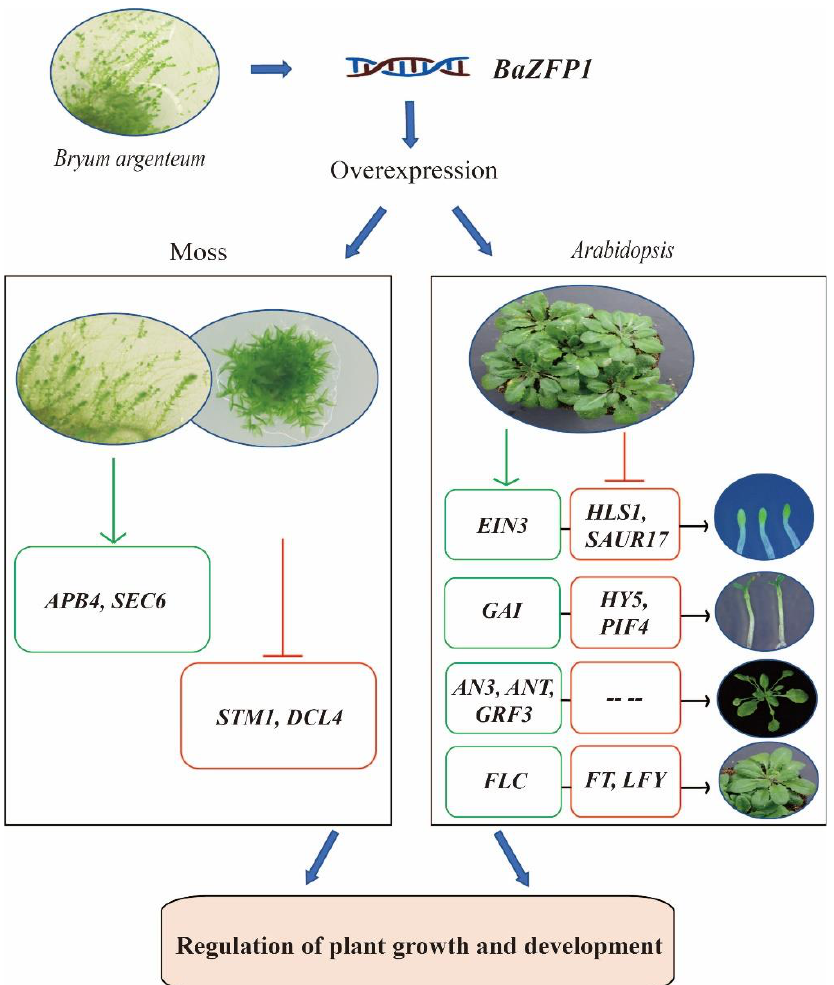
Figure 9. Proposed model explaining regulation of growth and plant development through BaZFP1 overexpression. Green and red indicate a relative increase and decrease in expression level, respec- tively.